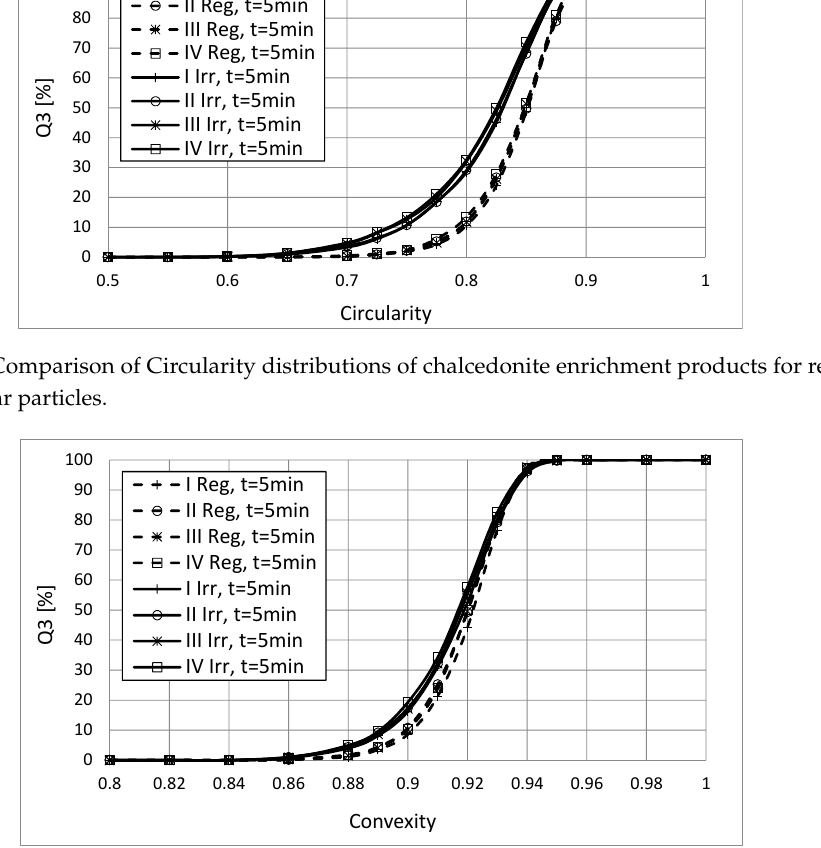
Figure 22. Comparison of Convexity distributions of chalcedonite enrichment products for regular and irregular particles.